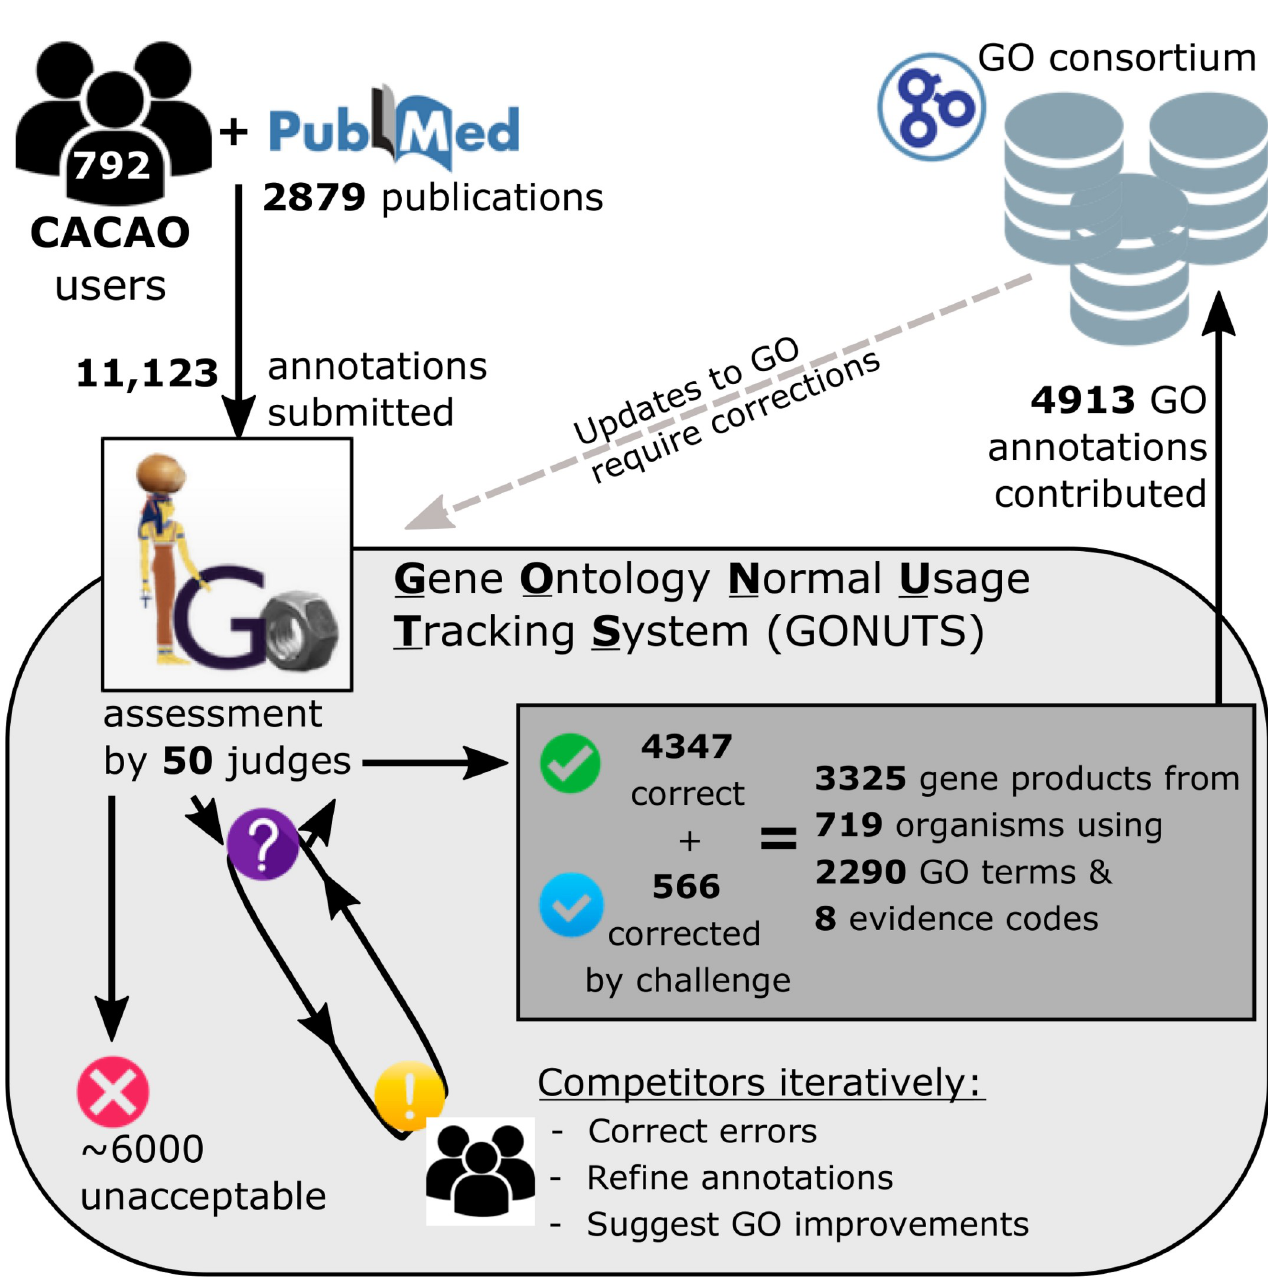
Fig 1. CACAO competitors contribute a large number of GO annotations. Overall CACAO contributions are summarized in the context of the workflow for quality control and submission to the GO Consortium. CACAO users consume the primary literature, collect information about normal gene functions from the paper study subjects, and capture the evidence and conclusions using the GO. Those annotations are reviewed by trained judges and marked as unacceptable (red X), requiring changes (yellow!, or purple? flagged for further review), or acceptable (green check, or blue check after correction) within the GONUTS framework. Competitors challenge entries and engage in peer review until an annotation is corrected or marked unacceptable. Fully vetted annotations are deposited into the public GO database maintained by professional biocurators and used by scientists worldwide. As required, CACAO-submitted